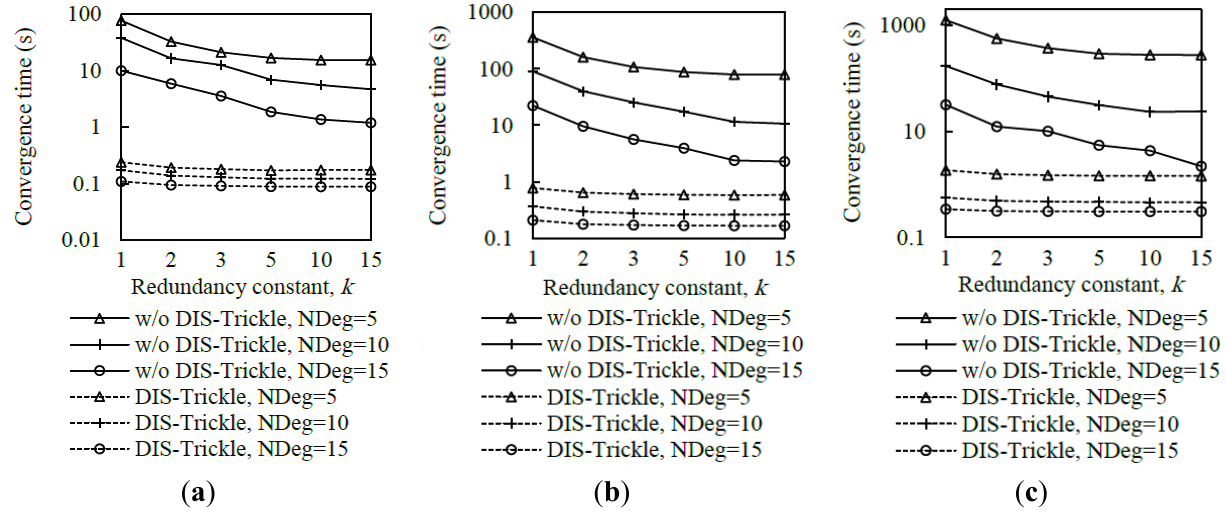
Figure 16. Influence of using DIS-Trickle on the total number of RPL messages ( i.e. , DIO and DIS messages) transmitted in the small, medium and large networks, for different average node degrees as a function of the redundancy constant, k , when the I